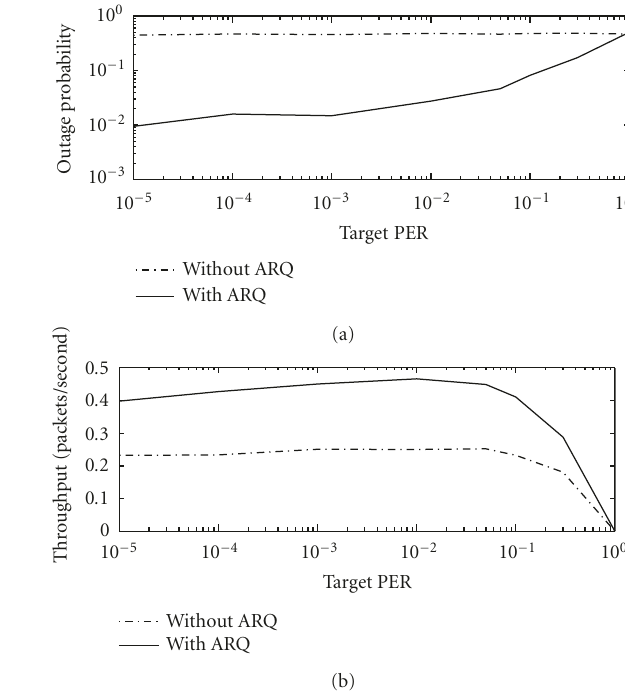
Figure 4: SMDP-based AC policy: outage probability and through- put for class 2 packets as a function of ρ = 10 − 4 . and ρ 1